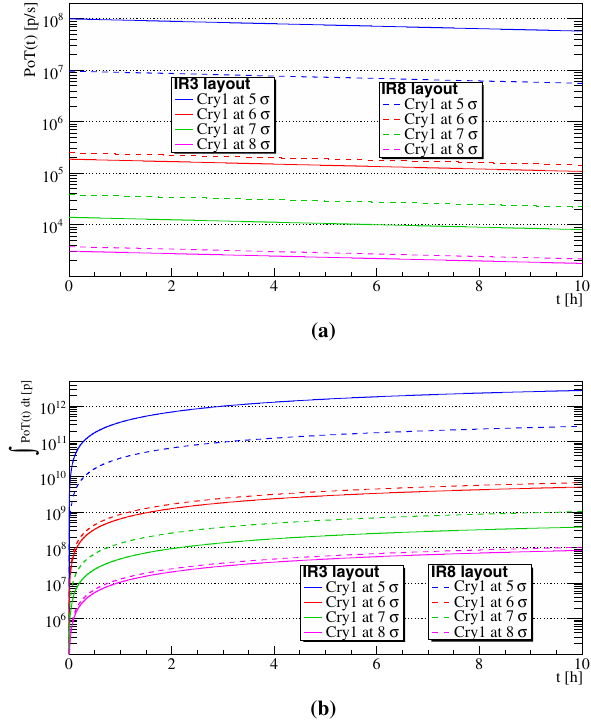
Fig. 9 Instantaneous ( a ) and integrated ( b ) PoT in a 10 h fill, for dif- ferent settings of Cry 1 . Expectations for the layouts in IR3 and IR8 are shown by the solid and dashed lines, respectively is dominated by the collisions in all experiments 5 and